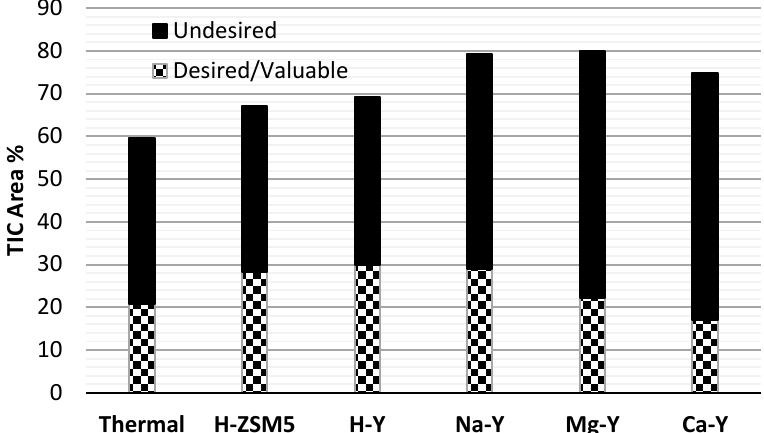
Figure 8. Effect of catalyst on the desired and undesired compounds of the bio-oil.